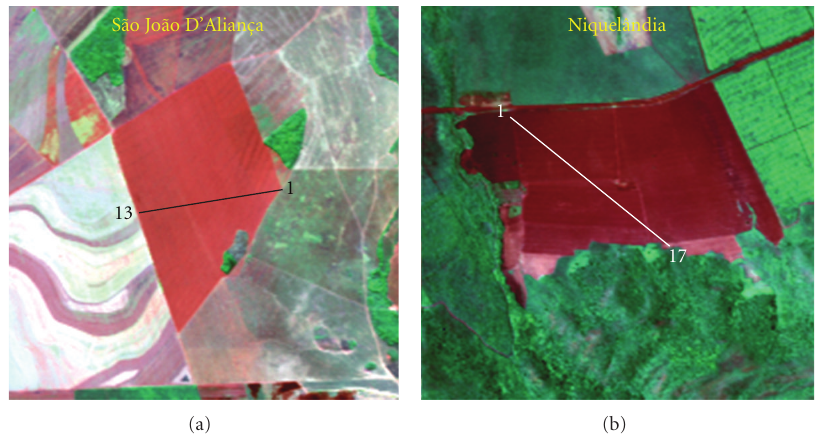
Figure 2: AVIRIS images of the areas, showing di ff erences in soil grey scale due to either the absence (SJA)or the presence (NIQ) of opaque minerals